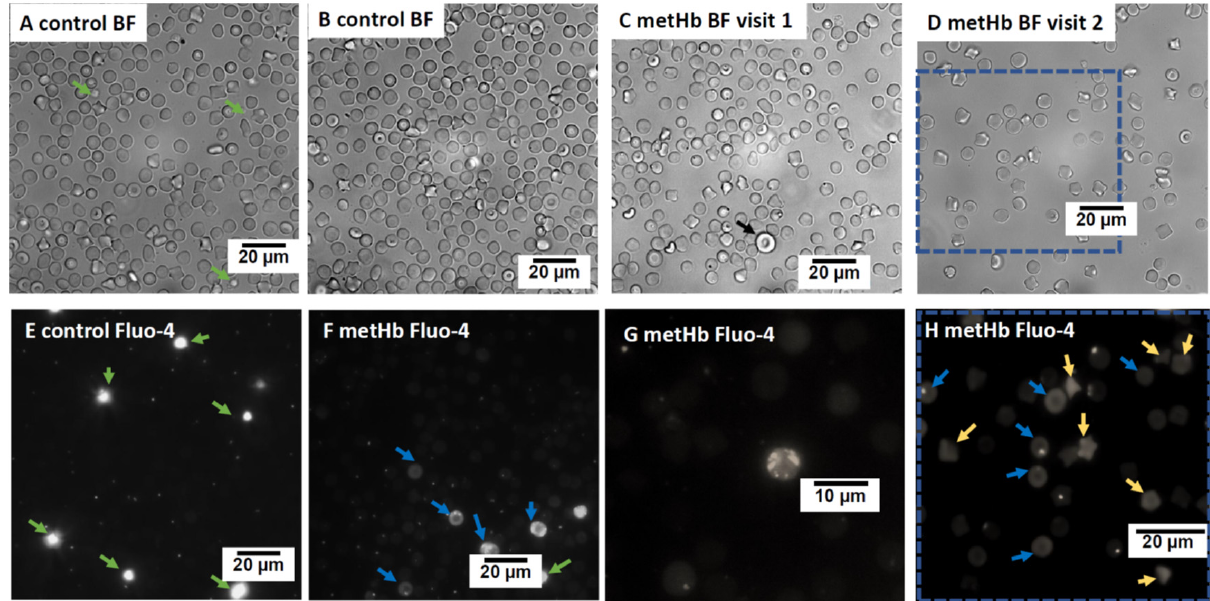
Figure 1. Microfluorescent live cell imaging of RBCs of the affected (metHb) and control cats. Bright field (BF) images of RBCs and Ca 2+ distribution (using fluorescent signal of Fluo-4 dye) from control and the affected cat. BF images of control ( A , B ) and the affected cat at first visit when the affected cat was anemic ( C ) and at second visit when in steady state ( D ). Panels E-H represent the Ca 2+ -dependent fluo-4 fluorescent signal for the RBCs of the control ( E ) and the affected ( F – H ) cats. Blue dotted frame indicates the BF and fluorescent images of the same area. Black arrow in panel C highlights an immature large RBC with distorted discoid shape. Platelets ( E , F ) are filled with Ca 2+ and intensely stained (green arrows). Some of the discocytes (blue arrows, ( F , H )) and echinocytes (yellow arrows, ( H )) of the affected cat were overloaded with Ca 2+ . A few Ca 2+ -overloaded cells of the affected cat contained multiple Ca 2+ -filled vesicles ( F , G ), which are characteristic for immature reticulocytes.